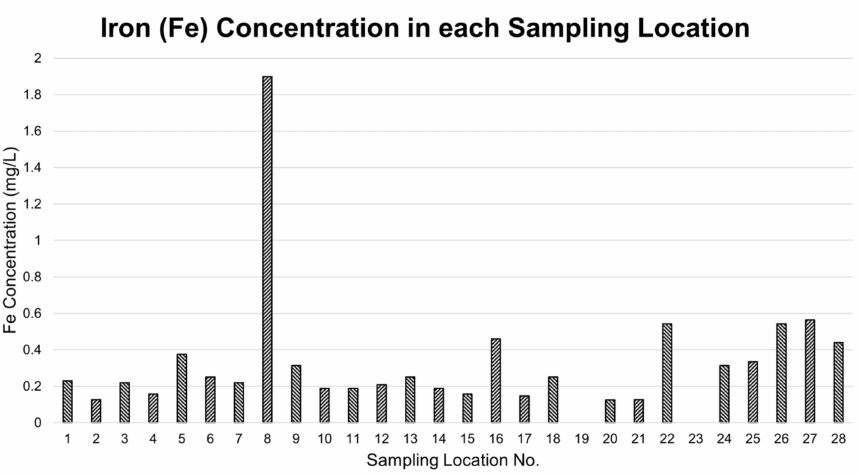
Figure 5. Concentration of Fe in GW samples.